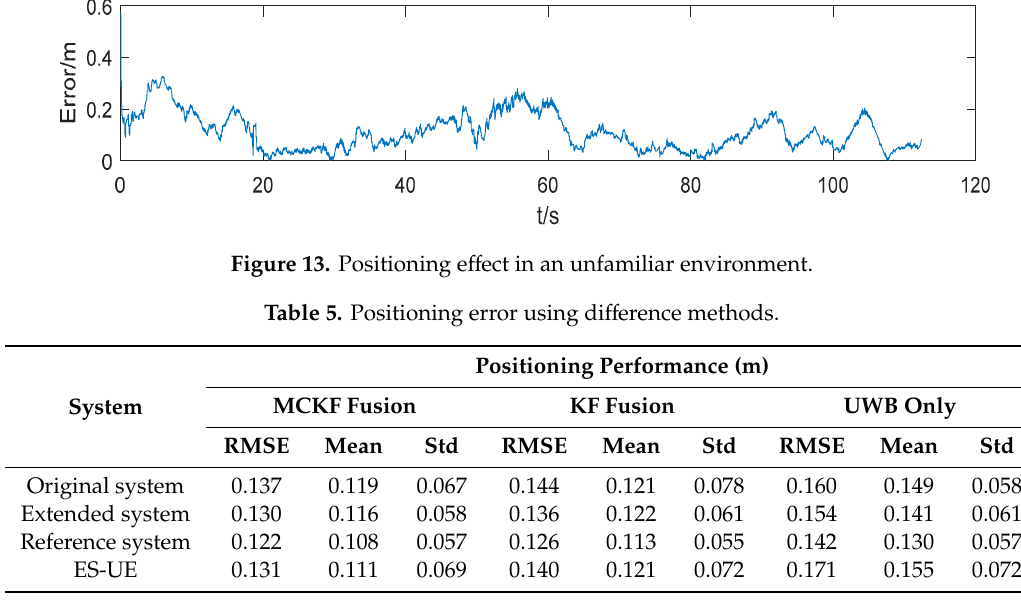
Figure 13. Positioning effect in an unfamiliar environment.